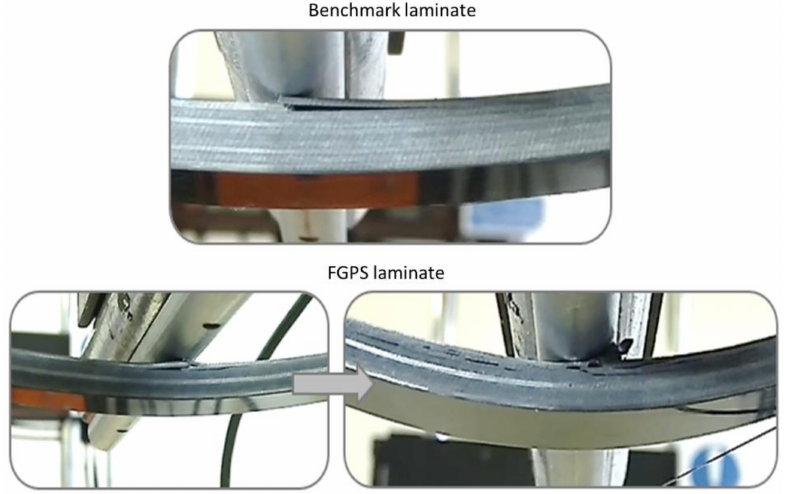
Figure 9. Initial damage propagation of the benchmark and FGPS laminates.